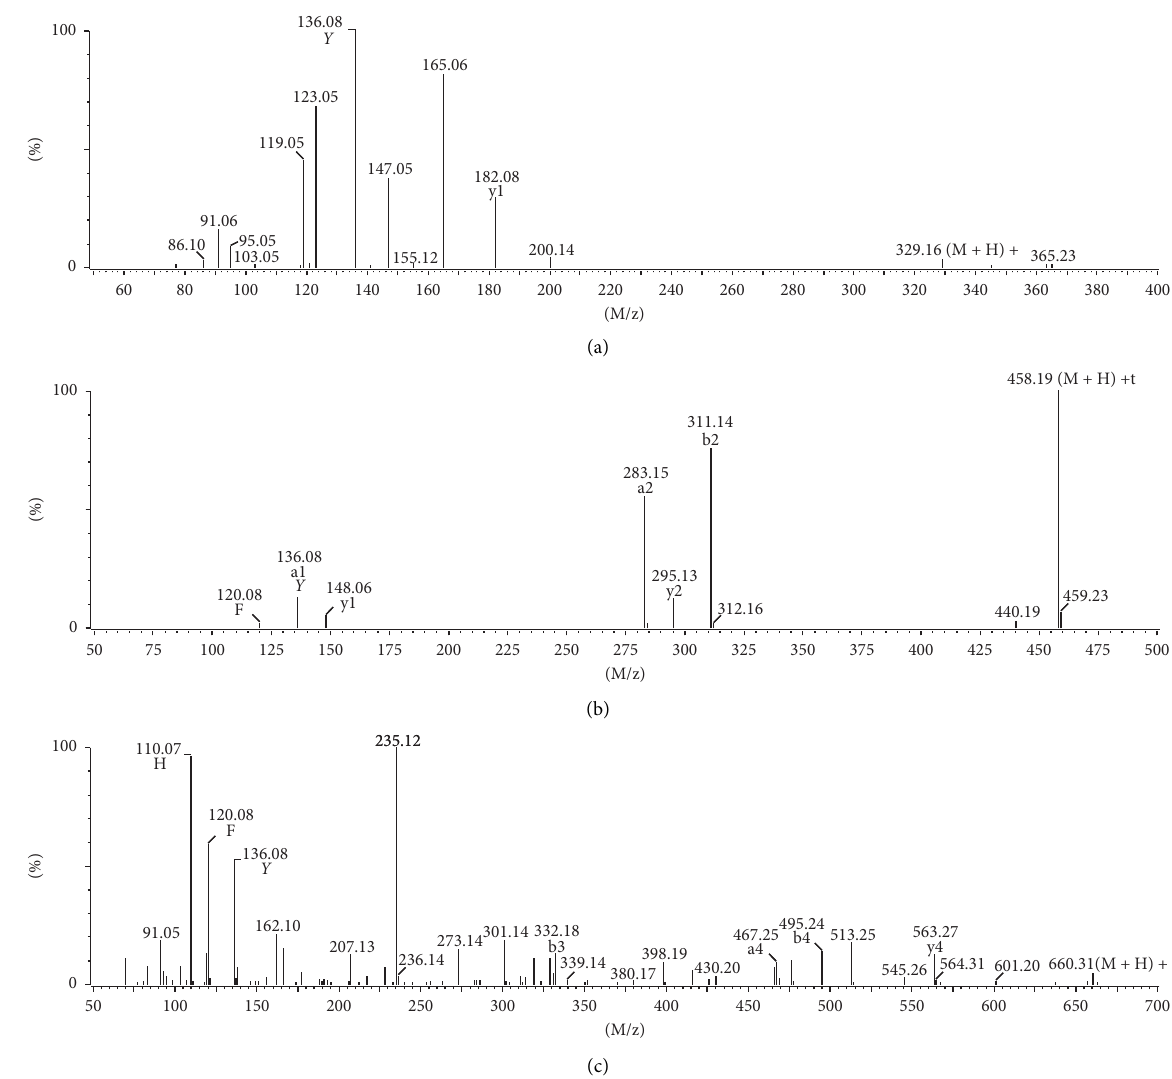
Figure 5: Tandem mass spectra of prominent peptides present in selected fractions. (a) Phe-Tyr. (b) Tyr-Phe-Glu. (c)